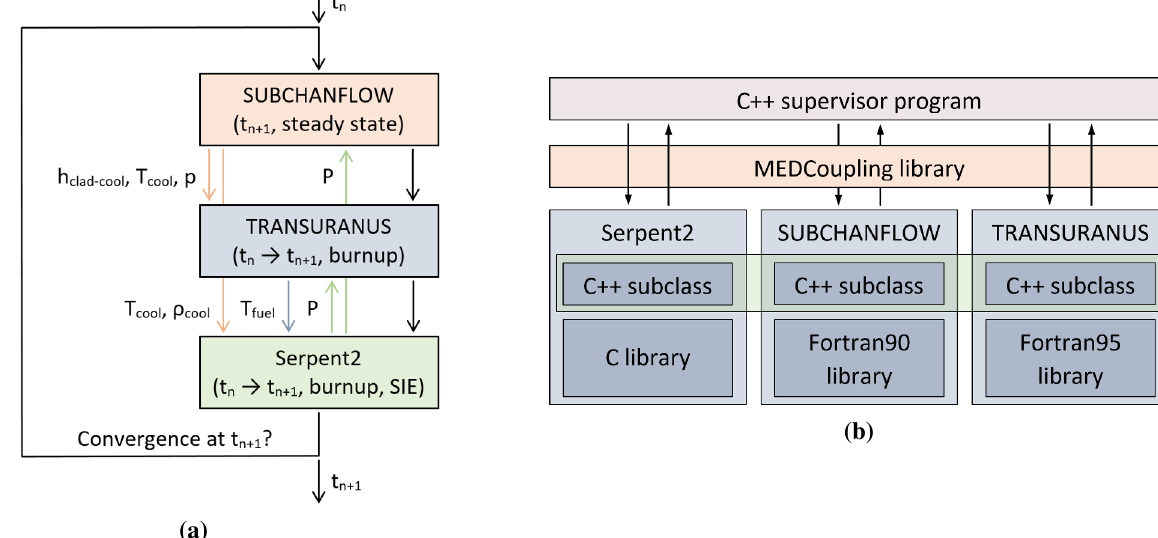
Figure 1: Depletion and feedback scheme (left), object-oriented software design